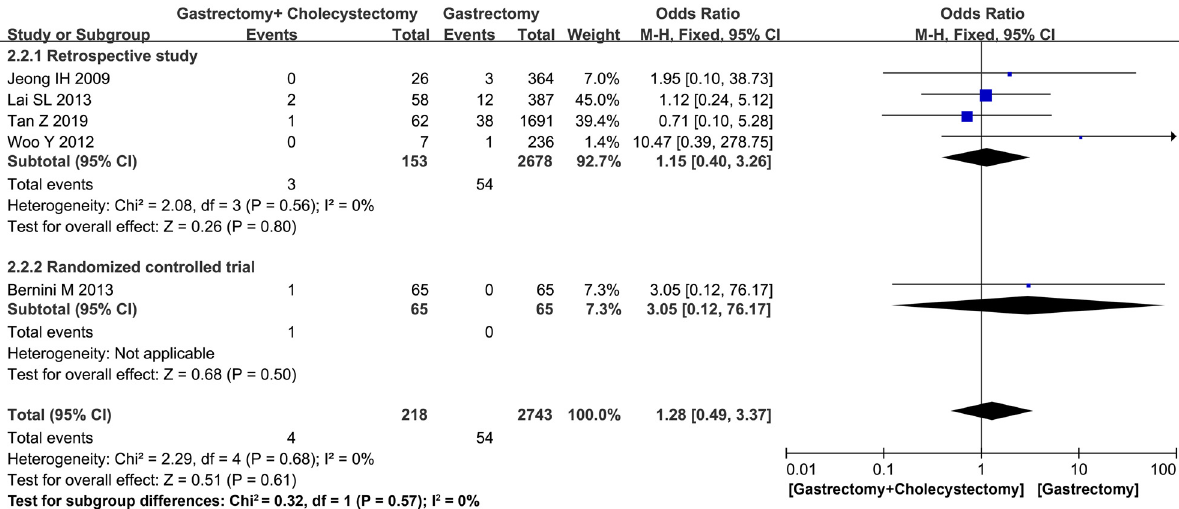
Figure 4: Forest plot showing postoperative mortality.